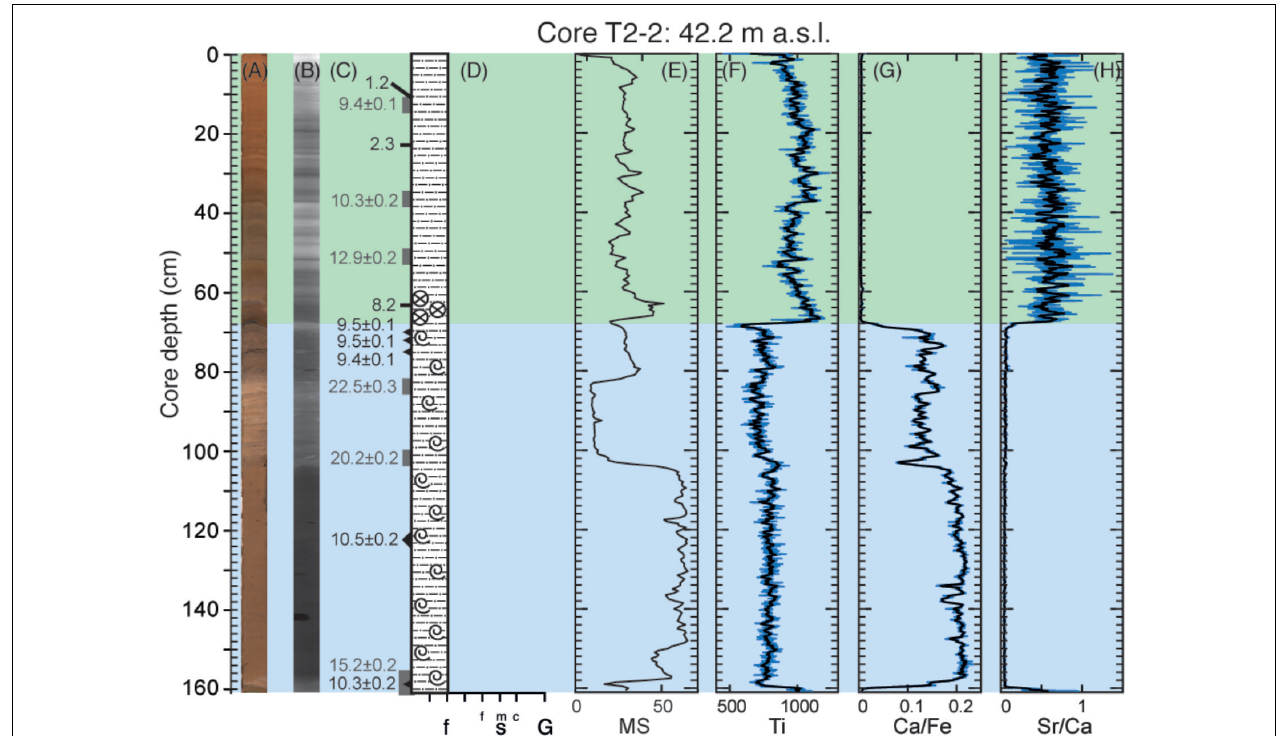
FIGURE 4 | Overview of Core T2-2. (A) High-resolution image of the core. (B) X-ray image. (C) Age and position of radiocarbon dates from foraminifera (black triangles) and ages inferred from paleomagnetic correlation (black lines). Gray boxes and gray text denote ages from bulk radiocarbon dating. (D) Lithologic log with grain sizes from fines (clay, silt) to sand and gravel. (E–H) Magnetic susceptibility measurement and content of Ti; Ca to Fe ratio; Sr to Ca ratio. Blue background color indicates marine conditions, green indicates lacustrine. Refer to Figure 2 for legend.